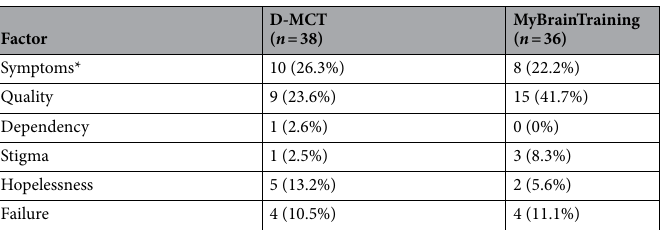
Table 4. Number of patients who reported at least one side effect associated with the study intervention. Multiple answers were possible. *The subscale “symptoms” of the Negative Effects Questionnaire (NEQ) was missing one item.